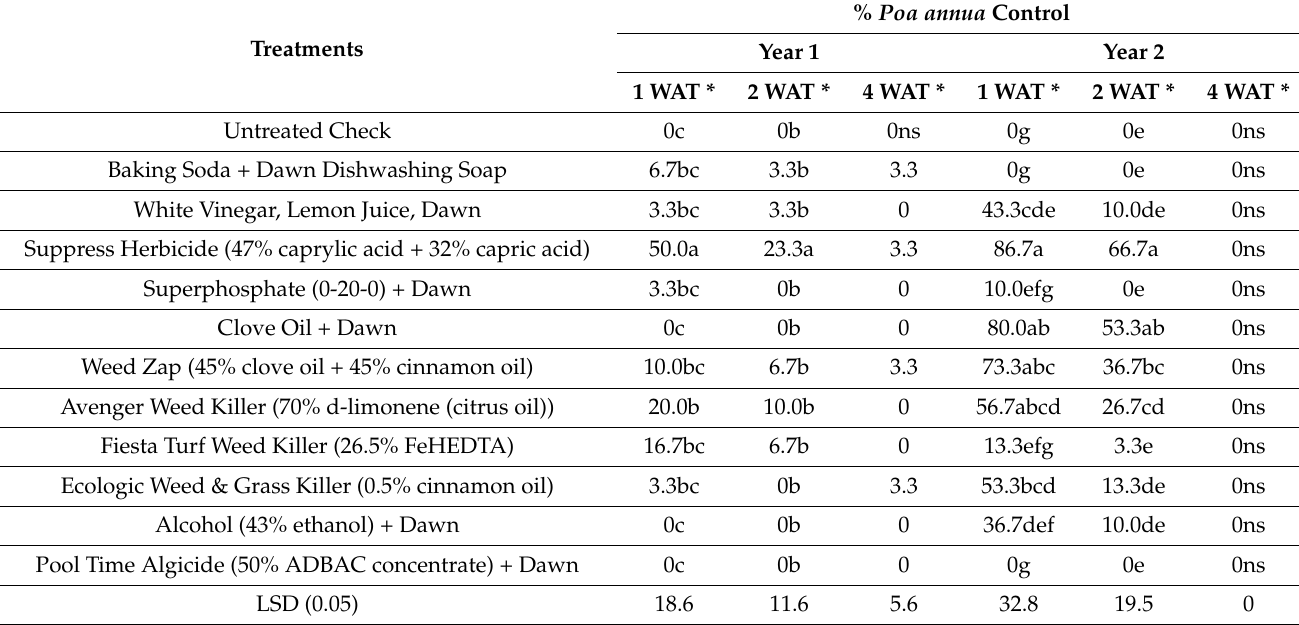
Table 2. Visual control of annual bluegrass from non-synthetic treatments. Different letters within a column indicate statistical differences.